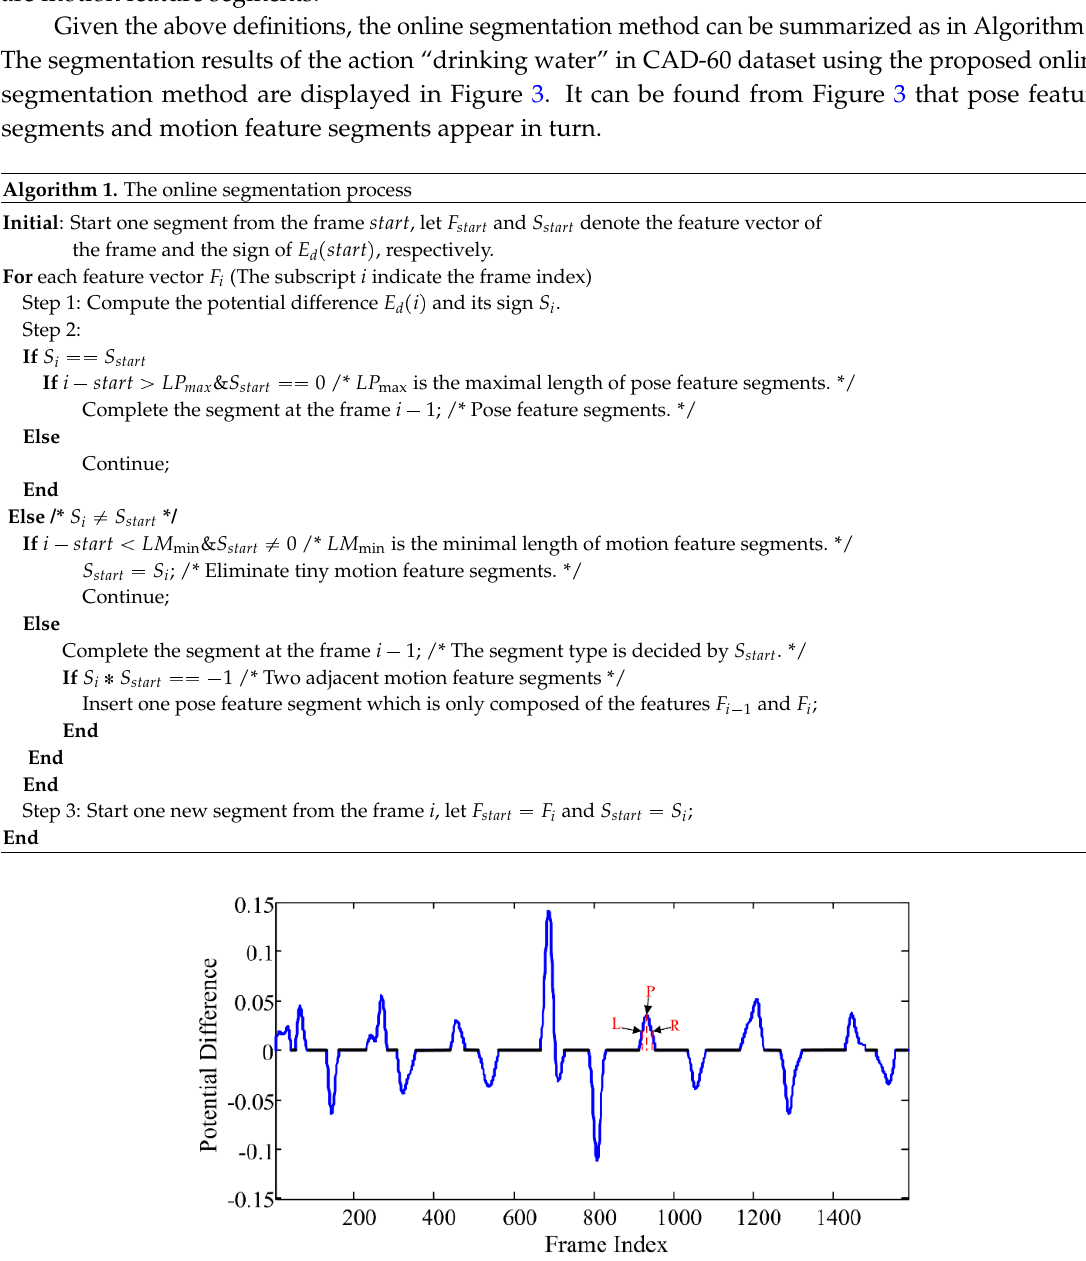
Algorithm 1. The online segmentation process